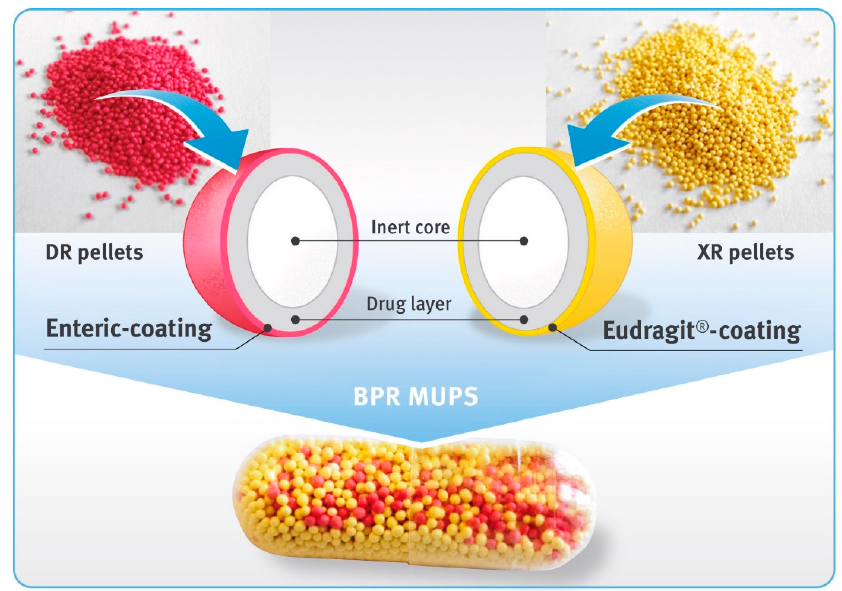
Figure 1. Diclofenac sodium 75 mg biphasic-release capsules comprising DR pellets (magenta beads) and XR pellets (yellow